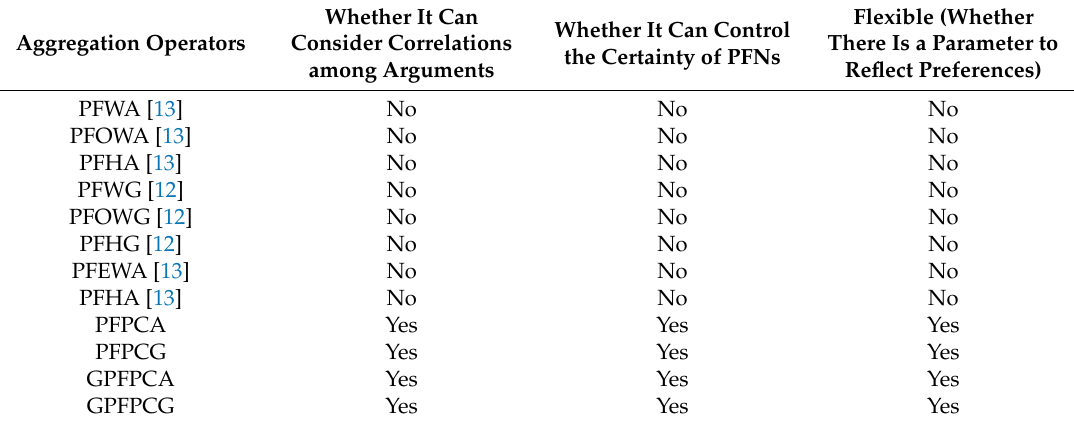
Table 6. The comparison of different